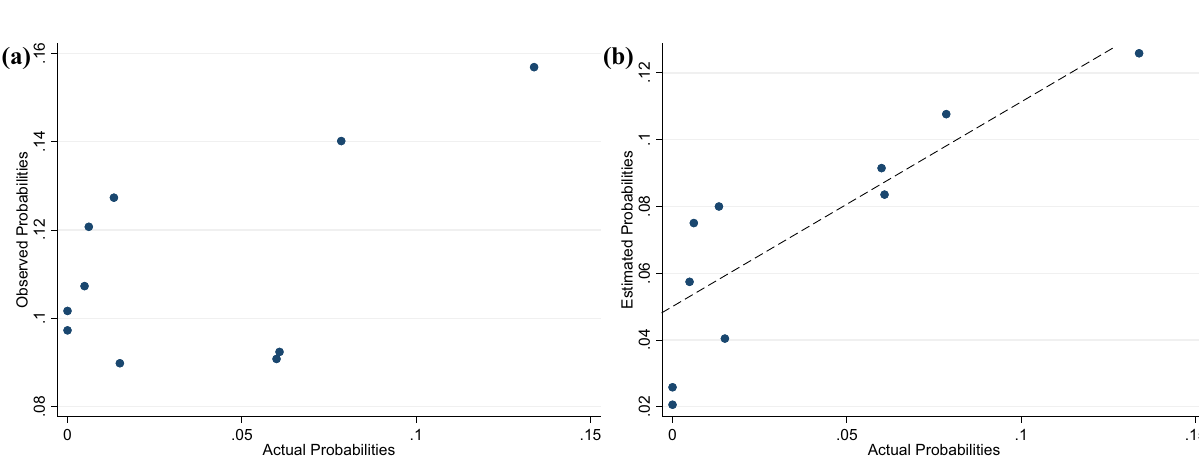
Figure 10. Comparing ( a ) observed and actual probabilities ( b ) estimated and actual